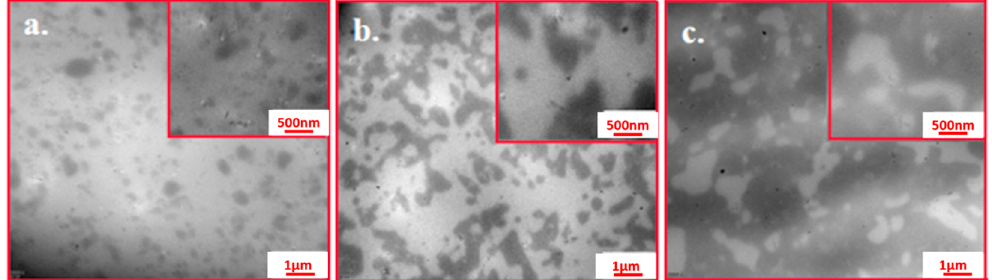
Figure 3. TEM micrographs of ( a ) NR/SBR (75/25), ( b ) NR/SBR (50/50), and ( c ) NR/SBR (25/75) blends.